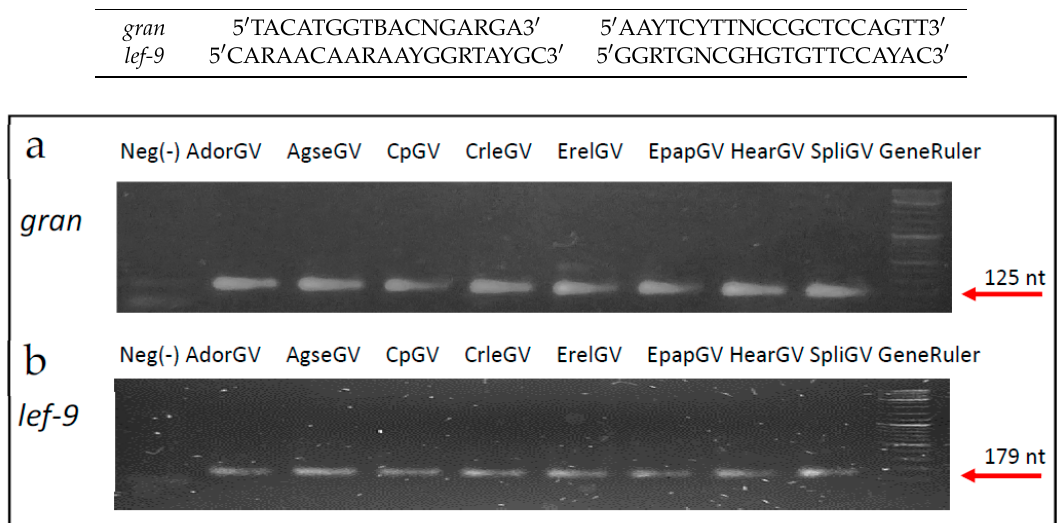
Figure 3. Agarose gel electrophoresis (2%) of PCR products of short fragments of gran ( a )—125 nt long and lef-9 ( b )—179 nt long prior to MSSCP analyses. First lane—negative control (w/o DNA), lanes 2–9 granuloviruses from this study, lane 10—Gene Ruler DNA Ladder mix, size of two the lowest bands are 100 and 200 base pairs (Thermo Fisher Scientific, Waltham, MA, USA).